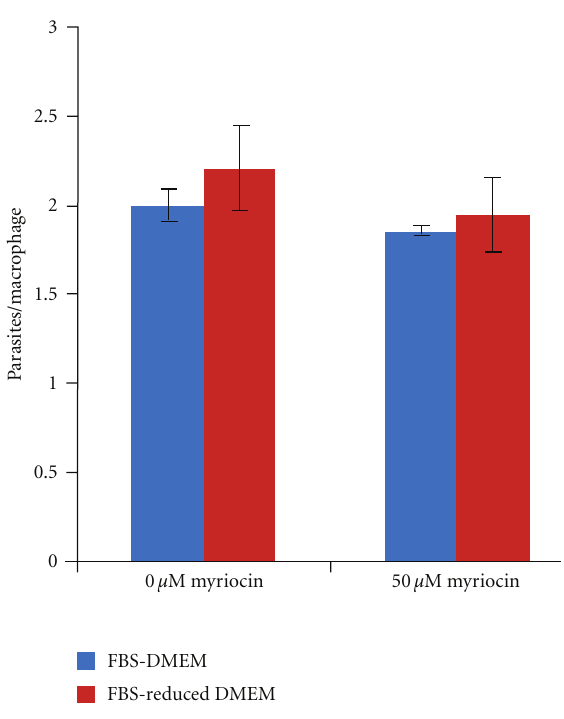
Figure 4: Proliferation, parasites per infected macrophage, deter- mined 48 hours post infection in the presence or absence of the SPT inhibitor myriocin, and with (FBS-DMEM) or without (FBS- reduced DMEM) exogenous serum in the media. Results of three independent experiments.